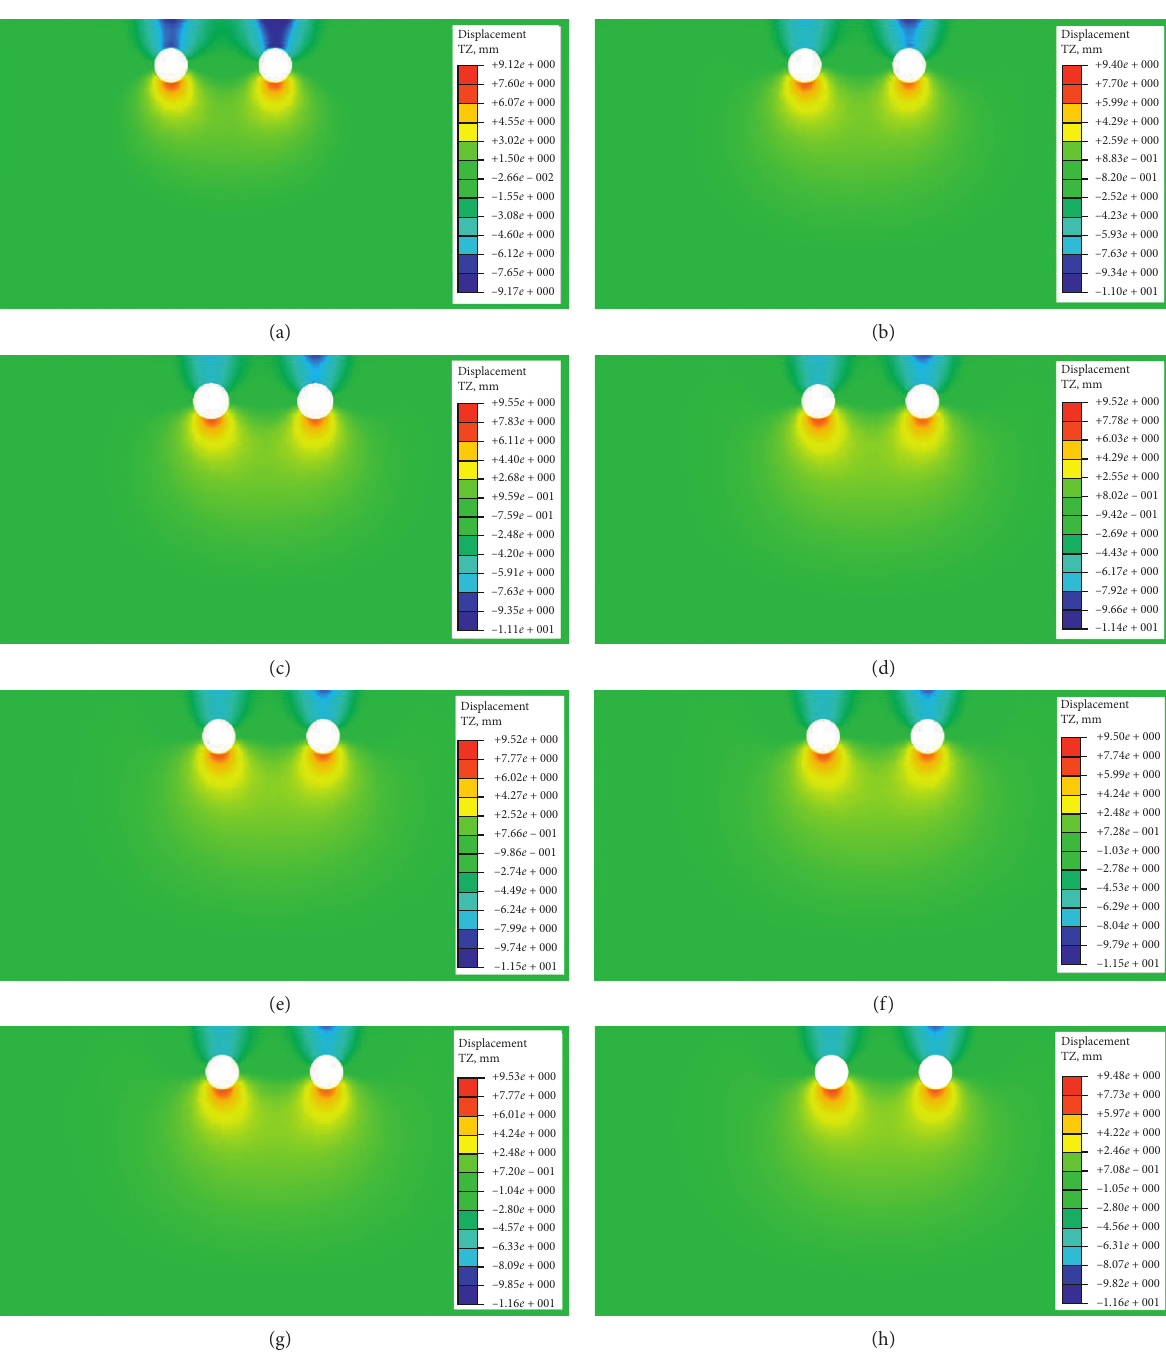
Figure 11: Contours of subsurface vertical ground displacements at the final step along Y � 30m induced by curved tunnelling at various radii of curvature: (a) 50m, (b) 100m, (c) 150m, (d) 200m, (e) 250m, (f) 300m (g) 400m, and (h)